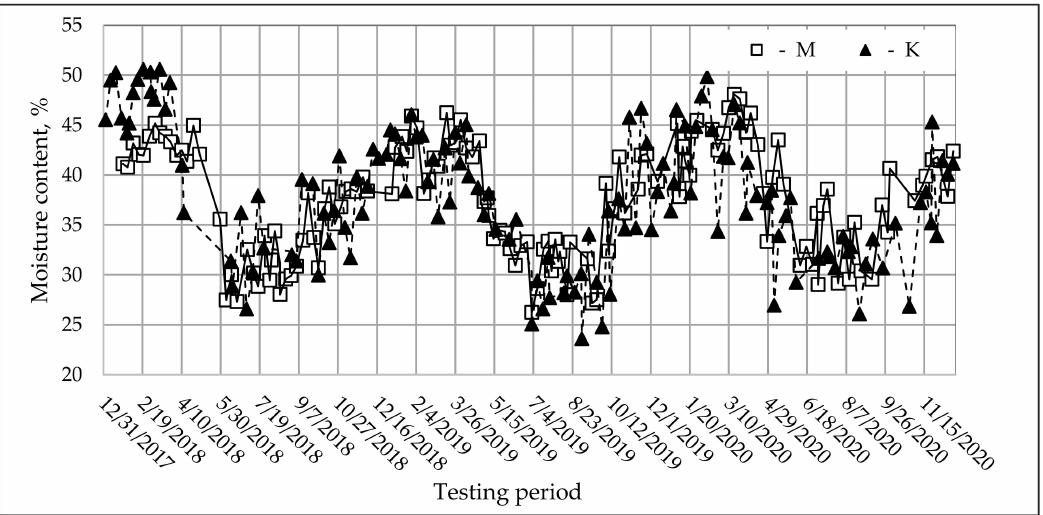
Figure 2. Daily average values of moisture content of wood chips supplied to companies M and